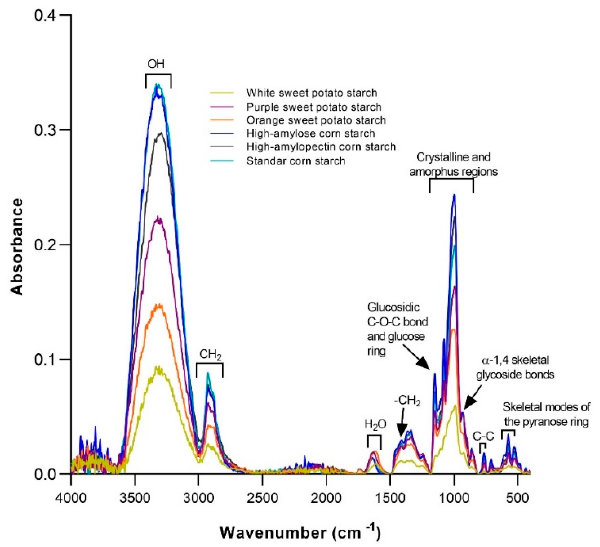
Figure 3. FTIR spectra from white, orange, and purple sweet potato (SP) starches as compared to corn starches (CS: high-amylose, high-amylopectin, and normal). Functional chemical groups in SP are quite like those found in CS, although with a variety-specific intensity. Absorption signals at 1048 and 1022 cm − 1 are associated with crystalline and amorphous starch regions, while the intense peak at 1000 cm − 1 can be attributed to amylose and amylopectin molecules. Source: The authors.